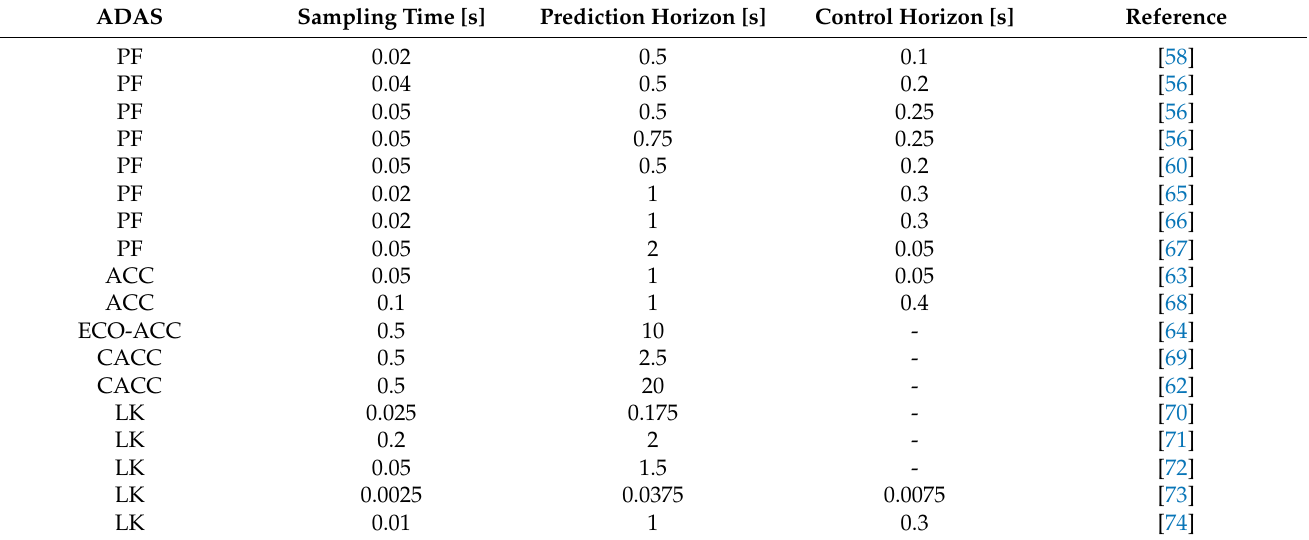
Table 1. Examples of sampling time, prediction and control horizons used in the literature for different advanced-driving assistance